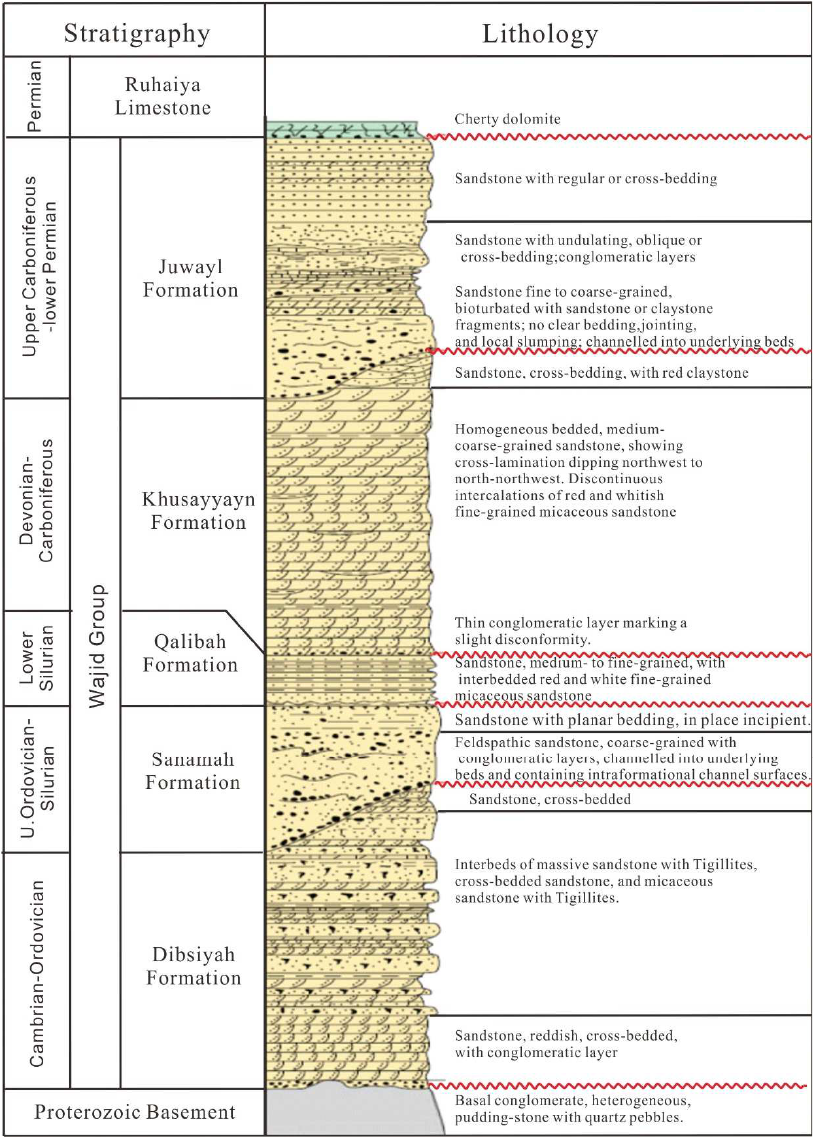
Figure 2. Lithology and sequence stratigraphy of the Wajid Group (Abdulkadir, 2013